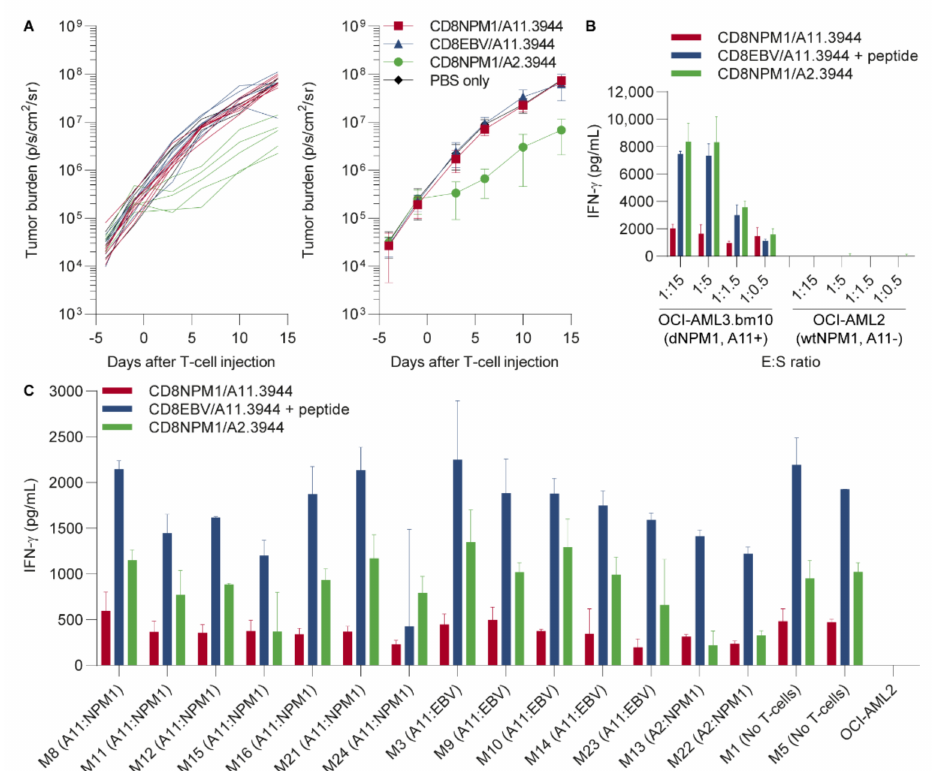
Figure 4. The HLA-A11-restricted TCR for dNPM1 does not target AML in mice. Male NSG mice were injected i.v. with 1 × 10 6 OCI-AML3.bm10 (HLA-A*02:01+, dNPM1) cells that were transduced with HLA-A11 and luciferase. CD8 T-cells from an HLA-A*02:01+ (HLA-A2) and HLA-A11+ healthy individual (donor 3944) were transduced with a TCR on day 2, purified on mouse TCR β chain expression on day 8 and injected on day 11. After 11 days of tumor engraftment, mice were infused i.v. with PBS or 6 × 10 6 CD8 T-cells transduced with the HLA-A11 dNPM1 or EBV TCR or the HLA-A2 dNPM1 TCR. Tumor growth was monitored for 2 weeks after T-cell injection, after which mice were sacrificed and bone marrow was harvested. ( A ) In vivo growth of luciferase-transduced OCI-AML3.bm10 cells was measured twice per week by bioluminescent imaging. Depicted is the tumor burden in individual mice (left panel) and per treatment group (right panel). No effect was observed in mice treated with T-cells with the HLA-A11 dNPM1 TCR ( n = 8, red line) or EBV TCR ( n = 7, blue line) or in mice receiving PBS ( n = 3, black line), whereas mice receiving HLA-A2 dNPM1 T-cells ( n = 5, green line) showed a reduction in tumor growth. Symbols represent mean ± SD; ( B ) T-cells were tested on the day of infusion for recognition of OCI-AML3.bm10 cells in vitro at different E:S ratios. IFN- γ secretion was measured after overnight incubation by ELISA. T-cells transduced with the HLA-A11 dNPM1 TCR (red bars) clearly recognized OCI-AML3.bm10 cells, although IFN- γ production was lower as compared to the HLA-A2 dNPM1 TCR (green bars) or EBV TCR (blue bars; OCI-AML3.bm10 loaded with 1 µ M EBV peptide). Bars represent mean + SD of duplicate wells; ( C ) Mouse bone marrow samples harvested 2 weeks after T-cell infusion were thawed and cultured for 3 weeks, and samples that showed outgrowth of AML cells were tested for T-cell recognition at an E:S ratio of 1:7.5. IFN- γ release was measured by ELISA after overnight incubation. TCR-transduced T-cells that were frozen on the day of infusion were thawed, stimulated and expanded for 11 days before testing. AML cells were also pulsed with a mix of dNPM1 and EBV peptides at a concentration of 500 nM per peptide. All AML samples were recognized by T-cells with the HLA-A11 dNPM1 TCR (red bars) or HLA-A2 dNPM1 TCR (green bars) and by T-cells with the EBV TCR (blue bars) after peptide loading, but IFN- γ release by T-cells with the HLA-A11 dNPM1 TCR was lower. Bars represent mean + SD of duplicate